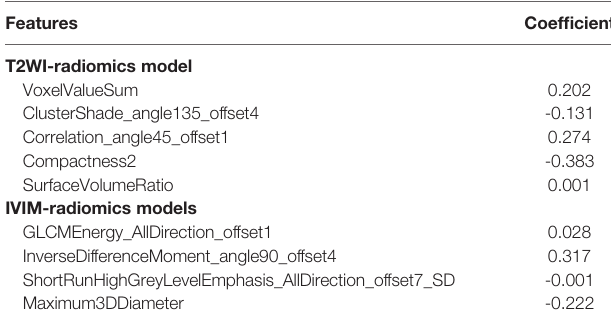
TABLE 4 | Selected radiomics features for T2WI-radiomics and IVIM-radiomics models.